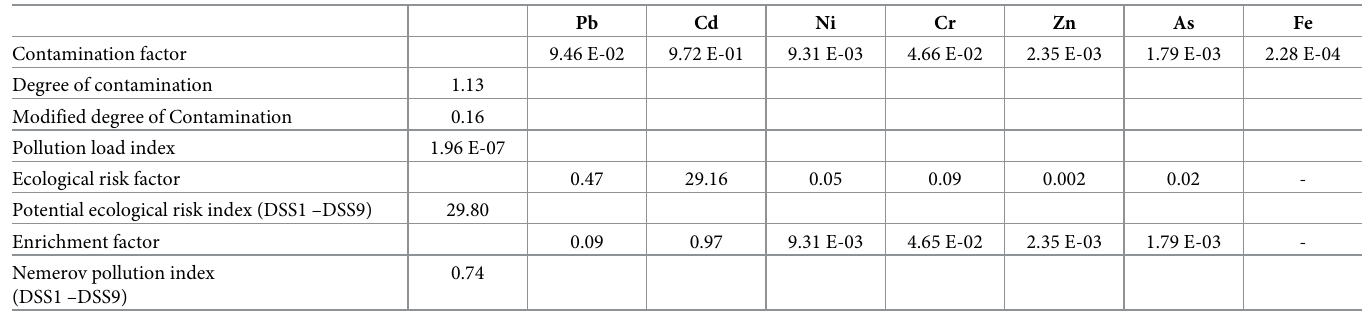
Table 7. Pollution indicators of heavy metals contamination of MSW dumpsite impacted sediment.